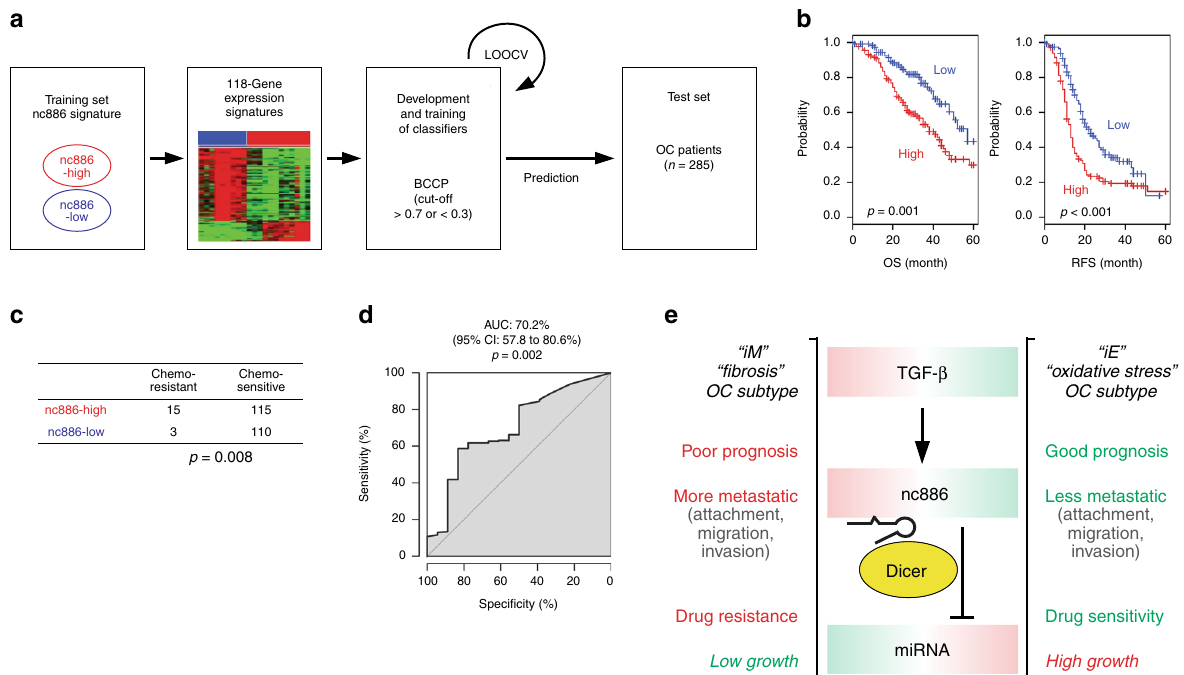
Fig. 7 nc886 association with poor clinical outcome and a summary model. a A schematic overview of the parameters of the prediction model. BCCP Bayesian Compound Covariate Predictor, LOOCV leave-one-out cross-validation. The cutoff of Bayesian probability: nc886 high >0.7 or nc886 low <0.3. b Kaplan – Meier plots of overall survival (OS) and recurrence-free survival (RFS). A total of 285 patients were strati fi ed into 2 groups, as predicted by the BCCP algorithm. P values were generated by the log-rank test. The + symbols in the panel indicate censored data. c A matrix table showing drug sensitivity of the two groups of OC patients. Of the 285 patients, 243 were included in this analysis by excluding patients with undetermined subtypes ( n = 33) and those without available chemotherapy data ( n = 9). P values were determined by χ 2 test. d ROC analyses for the discriminatory value of the nc886 signature in OC patients treated with chemotherapy. Bayesian probability of nc886 signature was used to identify patients who are resistant